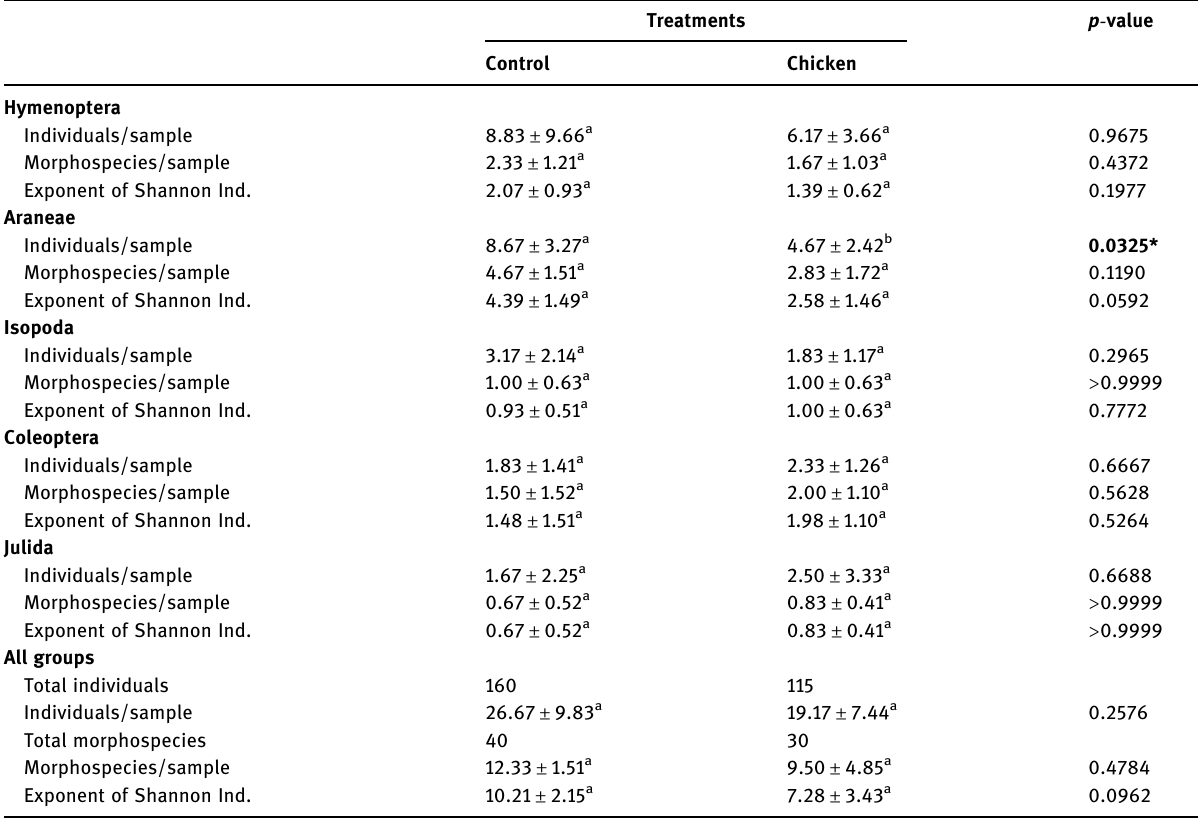
Table 2: Density of soil epigeic macrofauna and diversity ( exponent of Shannon index ) of the dominant groups and all groups, after grazing, at the orchard ( mean ± standard deviation